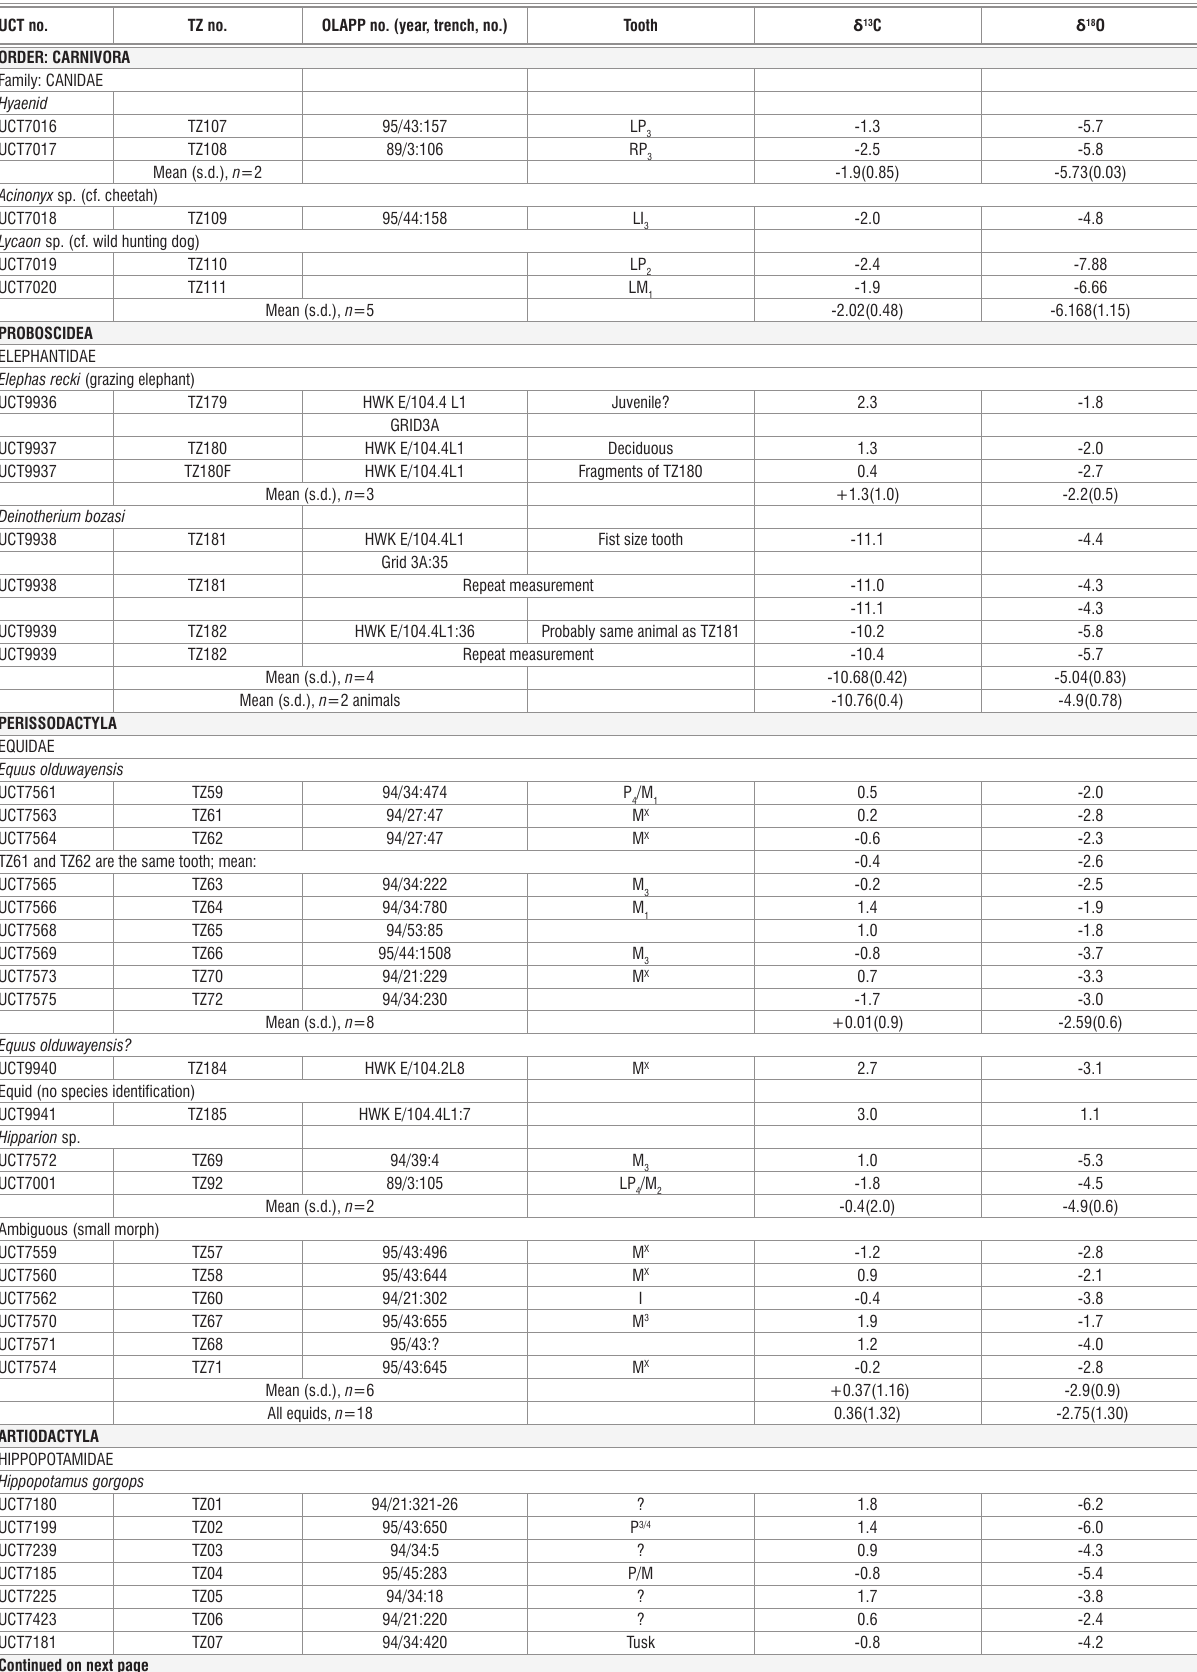
Table 2: Carbon and oxygen stable isotope ratios in tooth enamel of fossil fauna from Olduvai East Lowermost Bed II (plus three hippos from Lower Bed II). [Stratigraphy: overlying Tuff 1F: 1.75–1.78 Ma]. UCT no. TZ no. OLAPP no. (year, trench, no.) Tooth δ 13 C δ 18